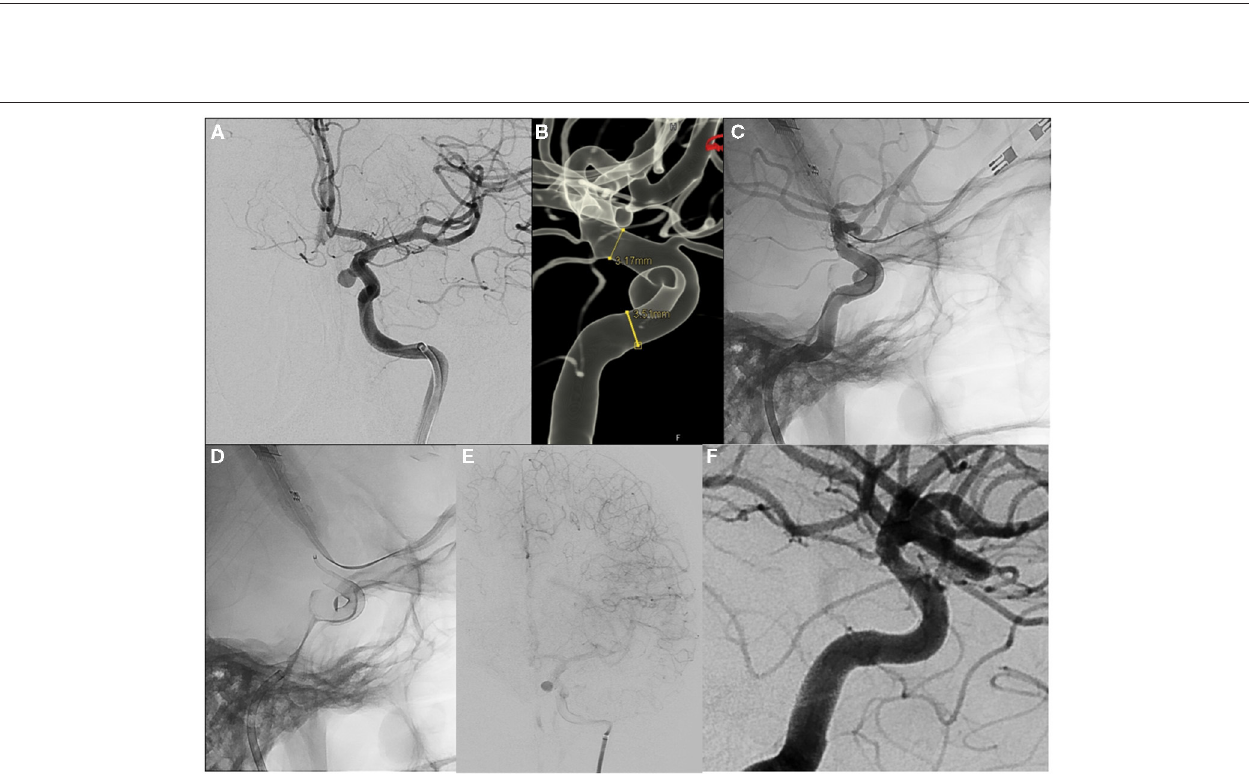
FIGURE 2 | DSA and reconstruction of 3D rotational of the right internal carotid artery (A,B) show a paraclinoid aneurysm. Silk Vista device 3.75 × 20mm is deployed through the Rebard 18 microcatheter, covering the neck of the aneurysm with a safety margin (C) , after which the microcatheter is advanced through the interior of the stent (D) . Postoperative angiography reveals a flow reduction (E) . The 4-month follow-up DSA shows complete occlusion of the aneurysm (F) .